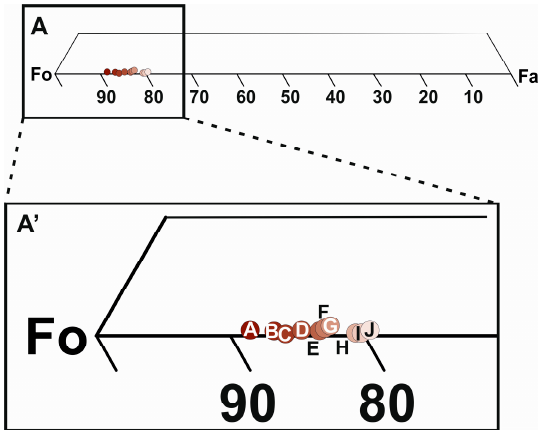
Figure 18. Classification diagram of identified olivines in samples collected from the Porto canyon area. A, D, and G are Fo mineral grains from sample P20; B, C and J are Fo mineral grains from sample P3; F and H are Fo mineral grains from sample P17; E is a Fo mineral grain from sample P3. In A’, it is possible to observe that the end member Fo ranged between 80 and 90%.